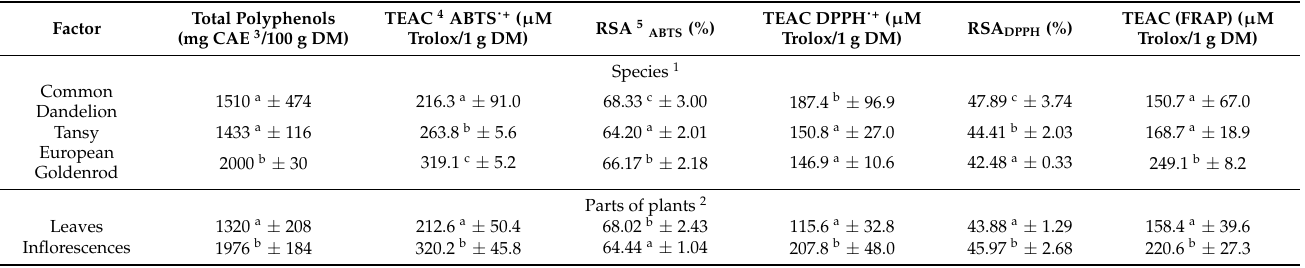
Table 2. The total content of polyphenols and antioxidant activity of Asteraceae family plants.